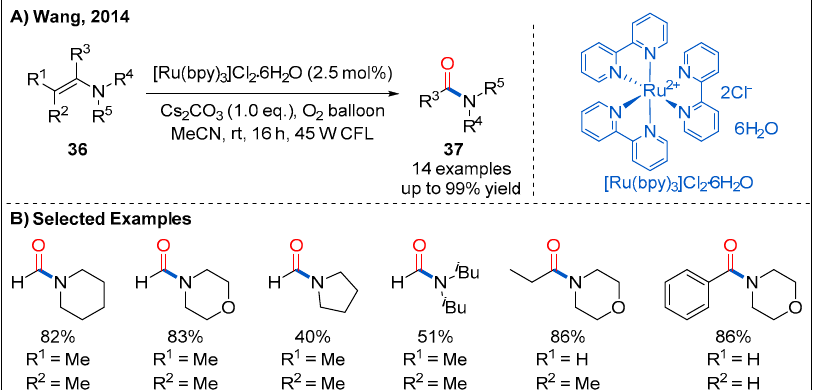
Figure 13. Visible light-promoted copper-catalyzed regioselective acetamidation of terminal alkynes.